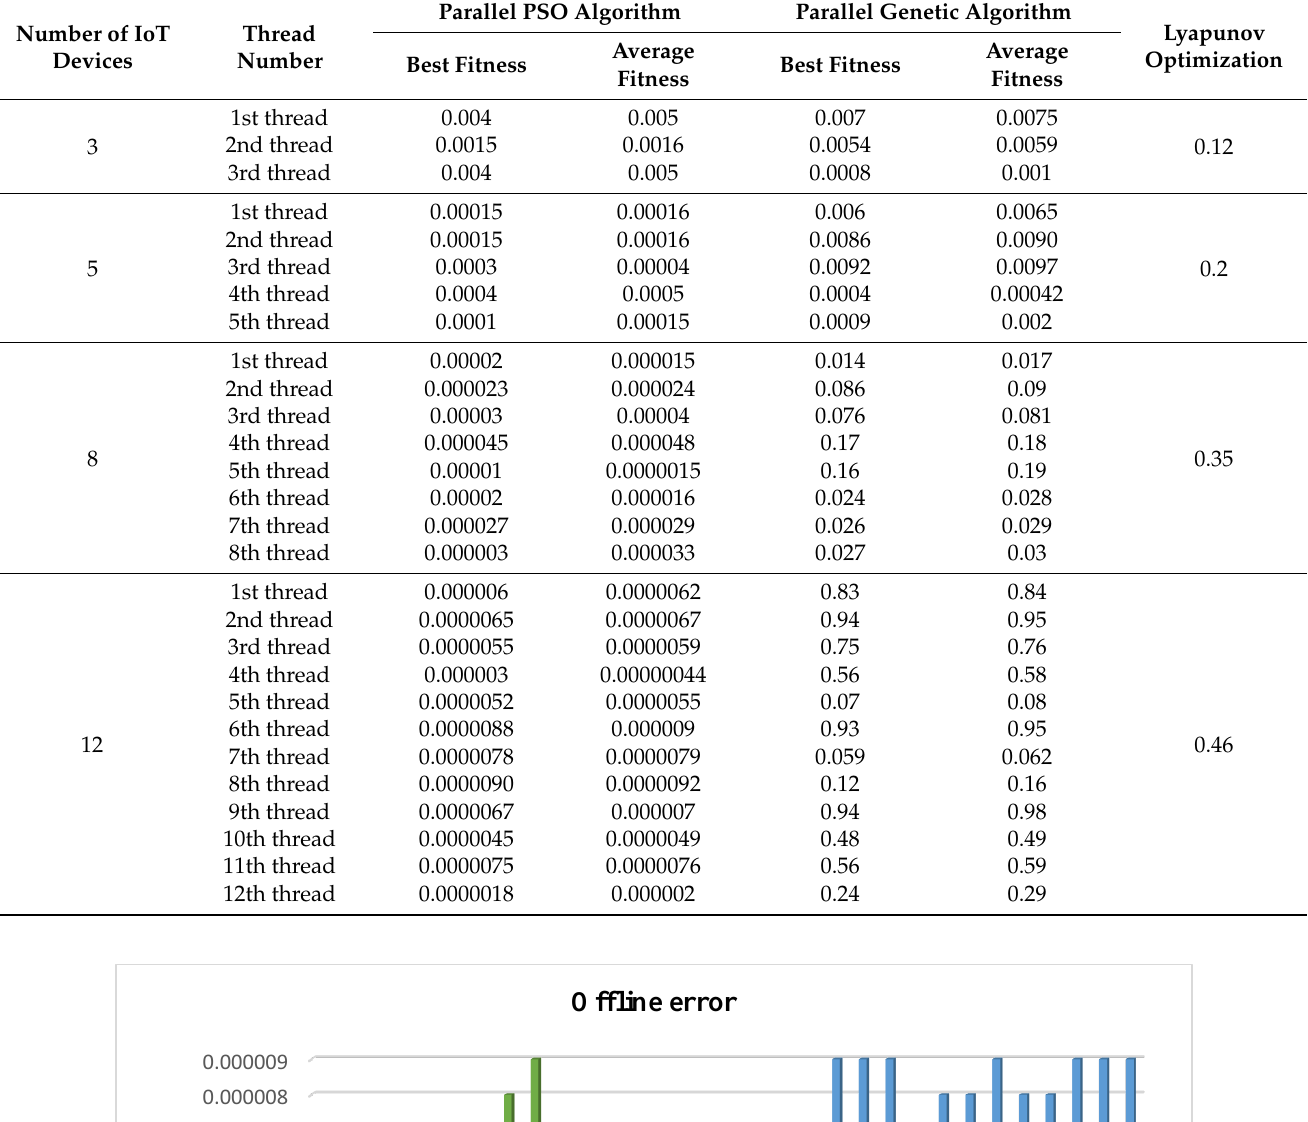
Table 3. Fitness value comparison.